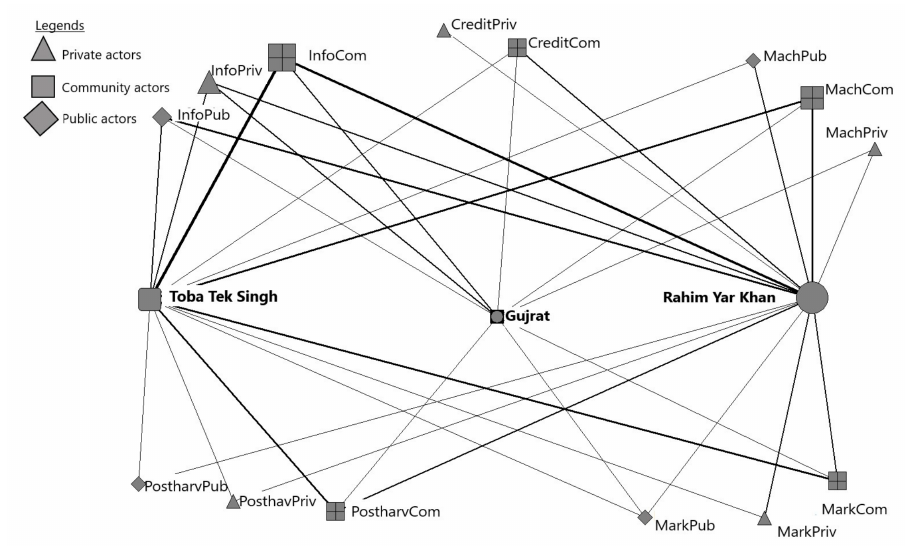
Figure 5. Social network showing linkages from farmers to financial services sources. Thick and bold links represent higher link densities between actors, while actor size is an indication of the number of linkages an actor has in the